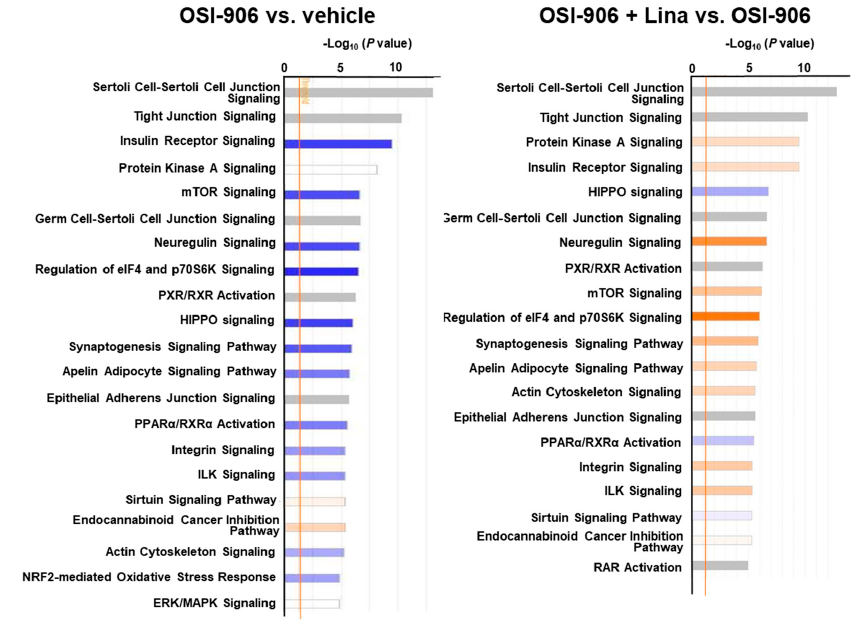
Figure 7. Canonical pathway analysis of phosphoproteomics in the livers of OSI-906- and linagliptin-treated mice. A canonical pathway analysis of the hepatic phosphoproteomic data was performed using molecules that were differentially expressed (ANOVA p < 0.05) in comparisons of OSI-906 vs. vehicle or OSI-906 + Lina vs. OSI-906. The color of the bar indicates the z-score (orange, positive z-score; blue, negative z-score). The orange line depicts the statistical significance threshold ( p = 0.05).